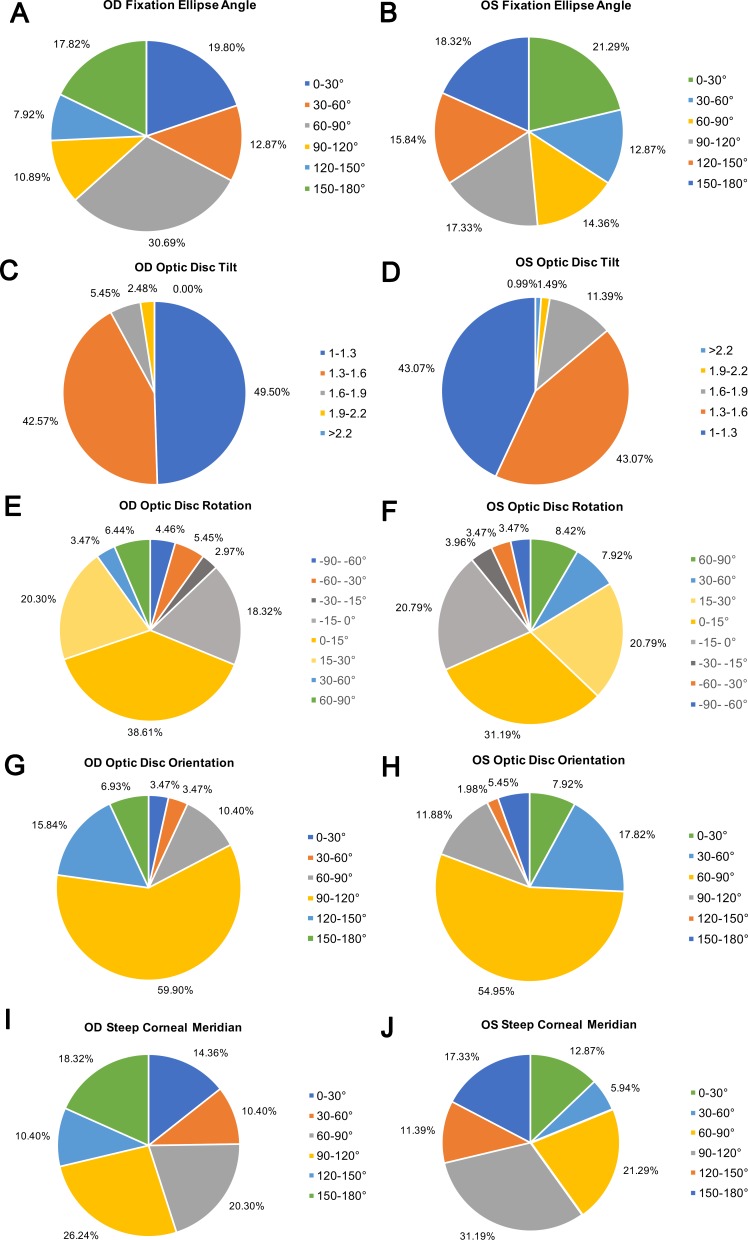
Distributions of the fixation ellipse angle (A, B), optic disc tilt (C, D), and rotation (E, F), orientation of the longest disc diameter (G, H), and steep corneal meridian (I, J) in the right and left eyes. The paired subfigures are colored as mirror images.